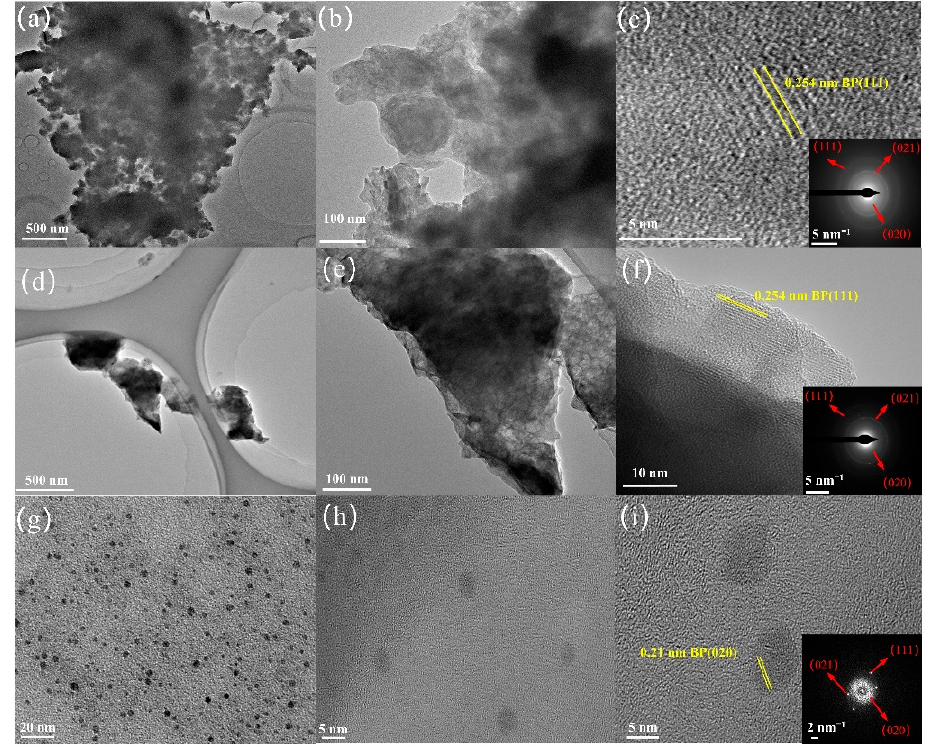
Figure 4. TEM images of the L-BP ( a – c ), M-BP ( d – f ), and BPQDs ( g – i ).